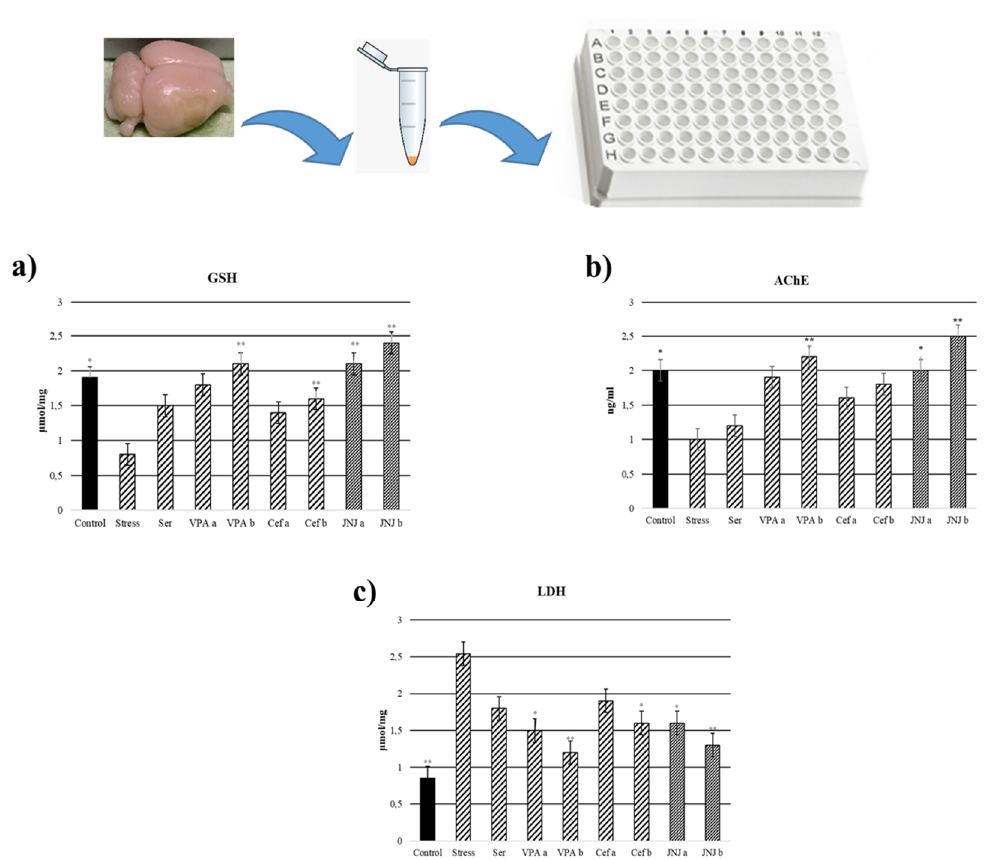
Figure 5. GSH, LDH, and acetylcholinesterase levels 30 days after treatment. ( a ) GSH levels ( µ mol/mg). ( b ) Acetylcholinesterase levels (ng/mL). ( c ) LDH levels ( µ mol/mg) after treatment. One-way ANOVA, * p < 0.05, ** p < 0.001 compared with the Stress group.